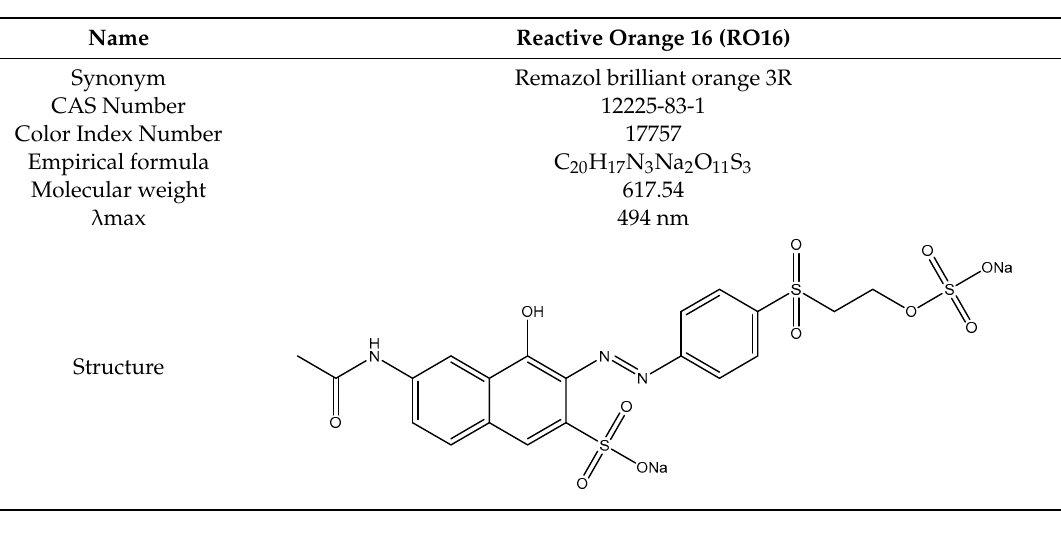
Table 6. Properties of Reactive Orange 16 dye.